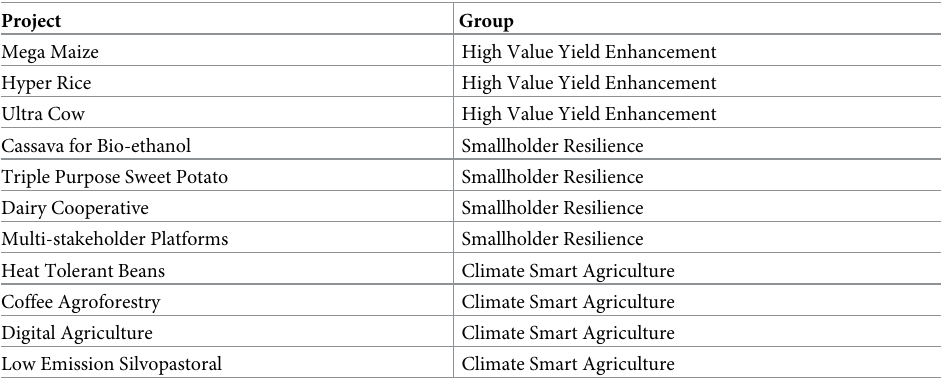
Table 1. Hypothetical list of AR4D